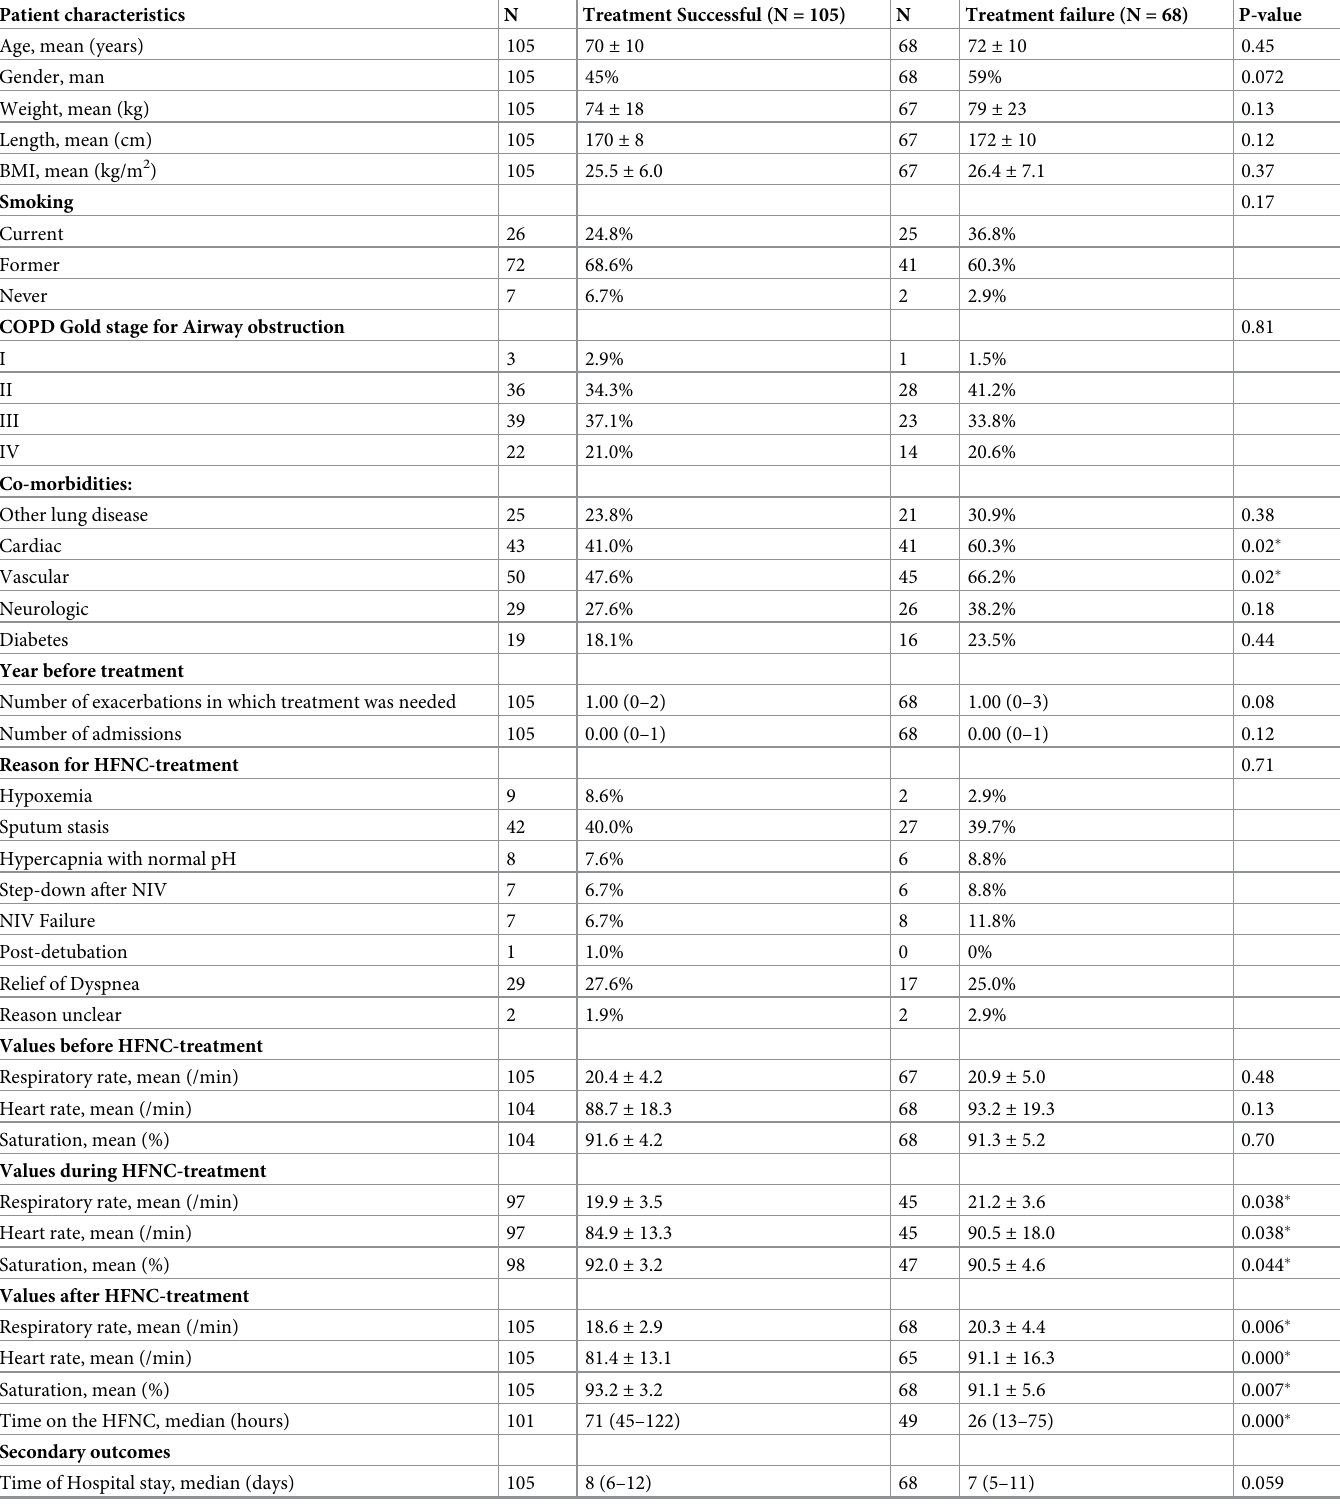
Table 4. Comparison between patients whom had successful treatment or wit treatment